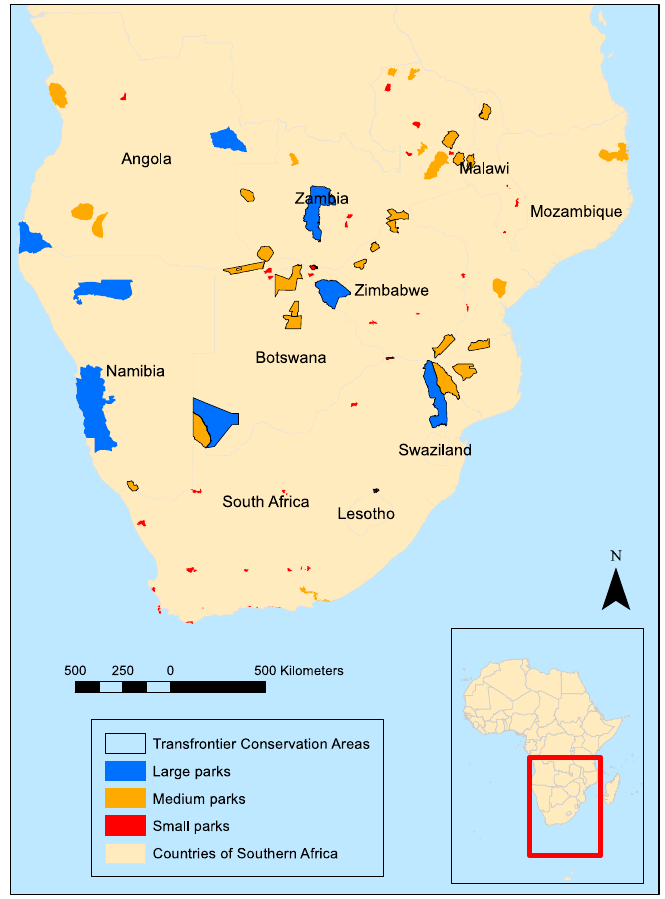
Figure 1. Southern Africa with national parks across the landscape and transfrontier parks highlighted.